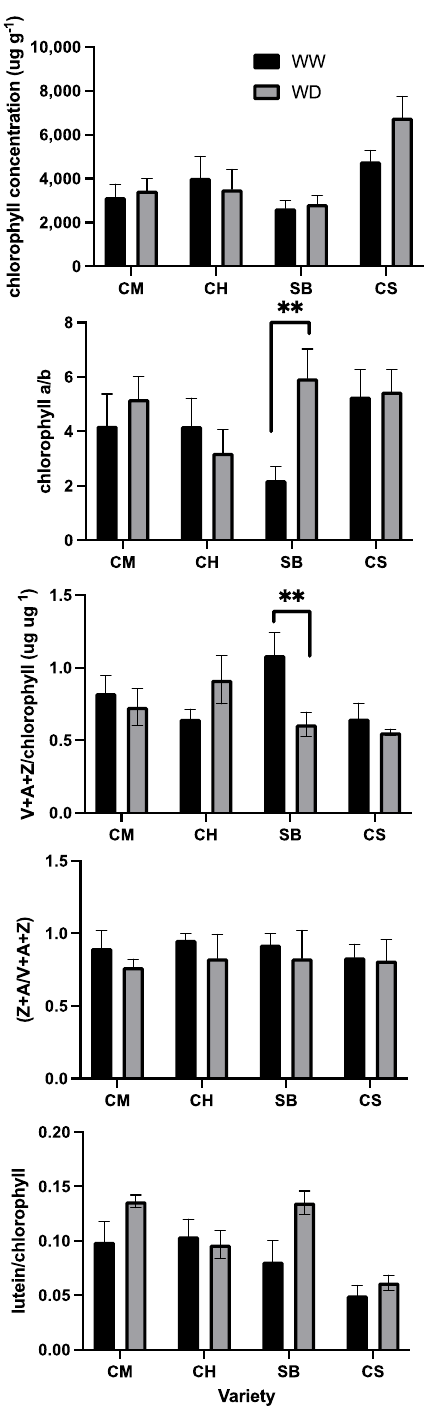
Figure 11. Pigment concentration in leaves, from top to bottom: Chlorophyll concentration; chlorophyll a to b ratio; the sum of violaxanthin (V), antheraxanthin (A) and zeaxanthin (Z) normalized by chlorophyll concentration, de-epoxidation state as Z+A/V+A+Z and finally lutein normalized by chlorophyll, for Carmenere (CM), Chardonnay (CH), Sauvignon blanc (SB) and Cabernet sauvignon (CS). WW in black bars and WD in grey bars. Error bars represent SE: Double asterisk represents significant differences between treatments for each variety p ≤